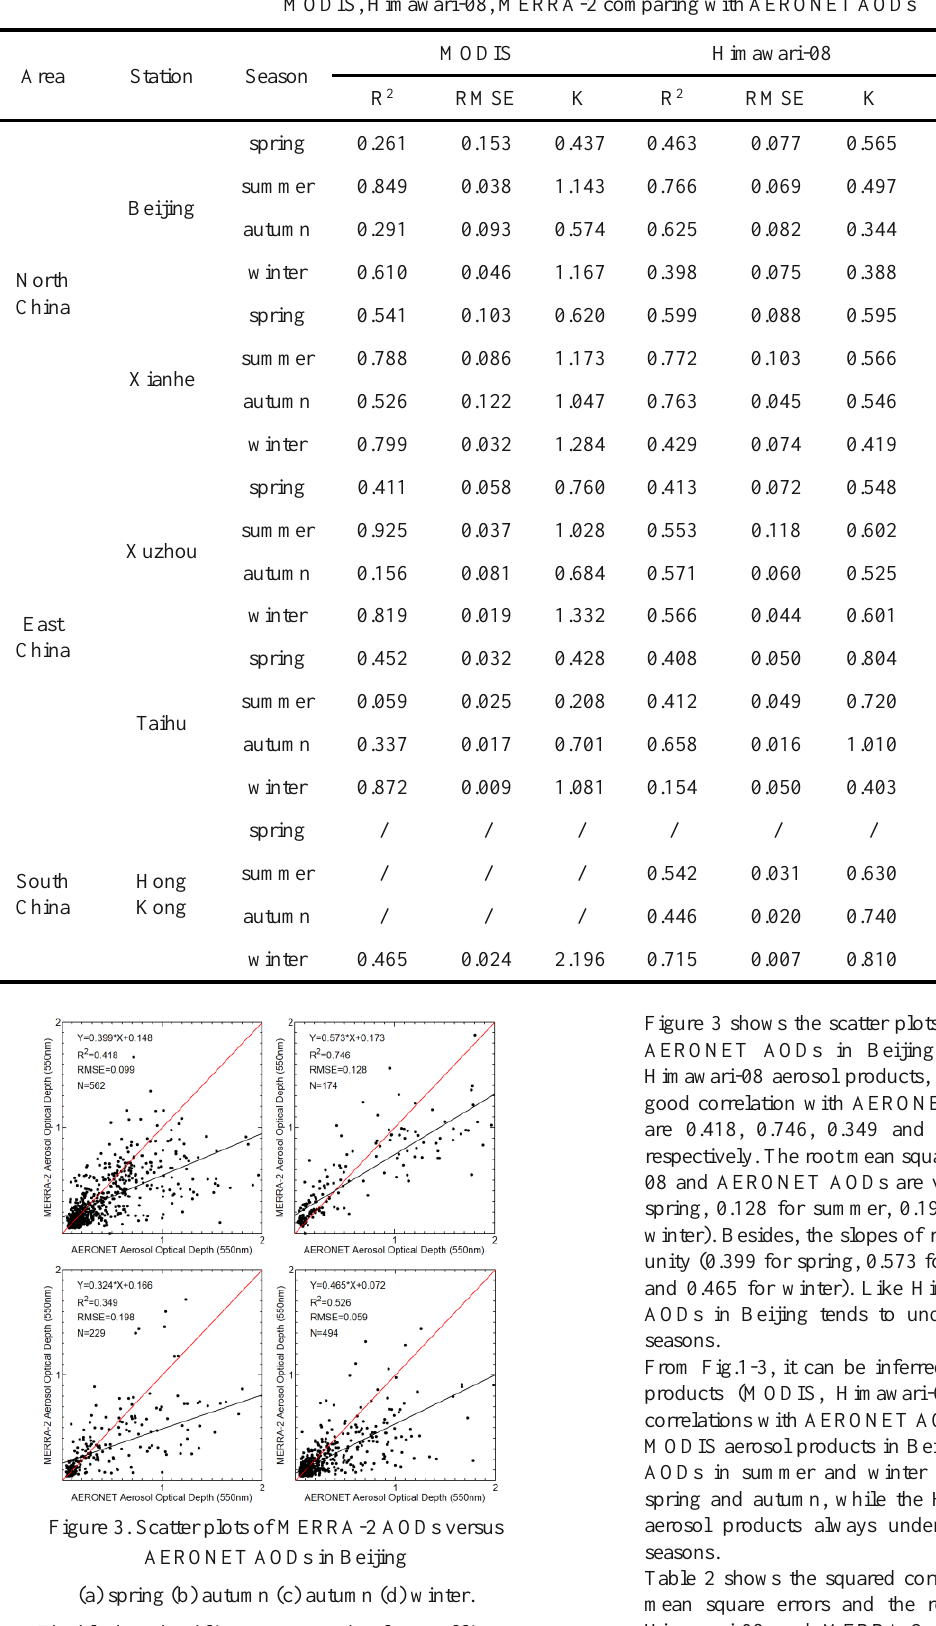
Figure 3. Scatter plots of MERRA-2 AODs versus AERONET AODs in Beijing (a) spring (b) autumn (c) autumn (d) winter. The black and red lines represent the slopes of linear regression and the 1:1 lines of scatter